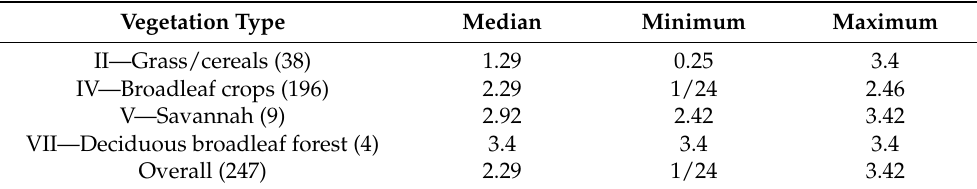
Table 4. Median, minimum, and maximum values for the travel time (in days) of the smoke for each of the land cover types found. The number of fires for each vegetation type is shown in parentheses.